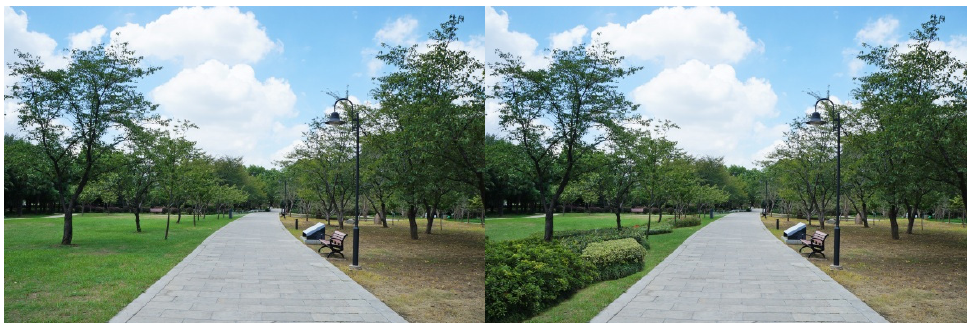
Figure 6. Example: Available seating (a bench and paved access pad were removed).